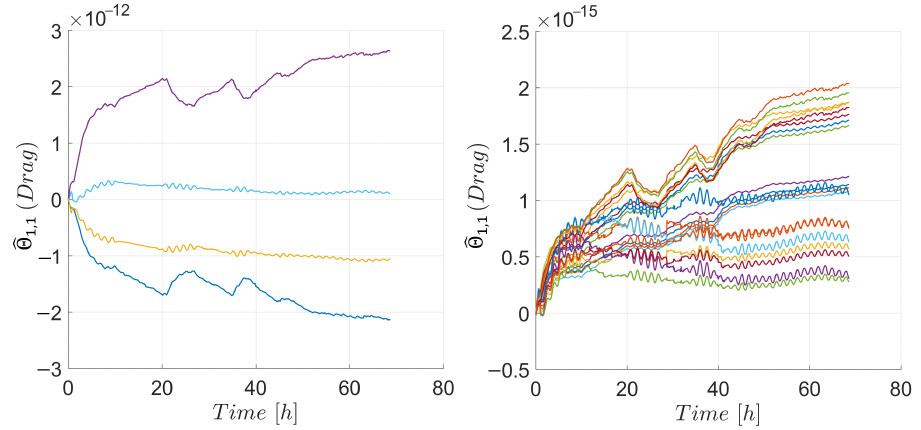
Figure 13. Parameter estimates from the attitude controller associated with the aerodynamic drag of the chaser. Components (cid:98) B 1 (cid:98) C D , j of (cid:98) Θ 1 , 1 with j = 1,2,3,4 ( left ), remaining components of (cid:98) Θ 1 , 1 ( right ).